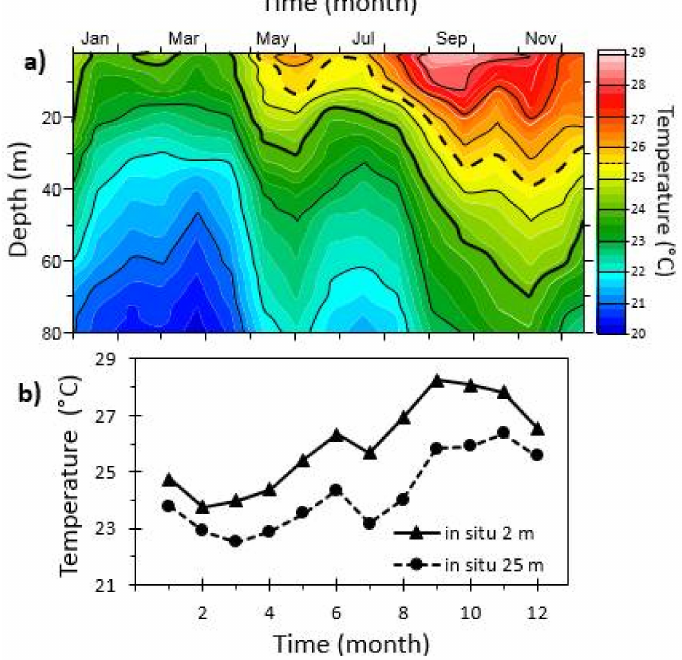
Figure 3. Seasonal averages of in situ temperature-depth profiles in the southeastern Caribbean. ( a ) Long-term seasonal temperature profile of the upper 80 m depth. ( b ) Long-term seasonal temperature extracted at 2 m and 25 m depths. Seasonal averages calculated from monthly profiles of 1 m depth interval (1996–2013) taken at the CARIACO Ocean Time-Series station (Figure